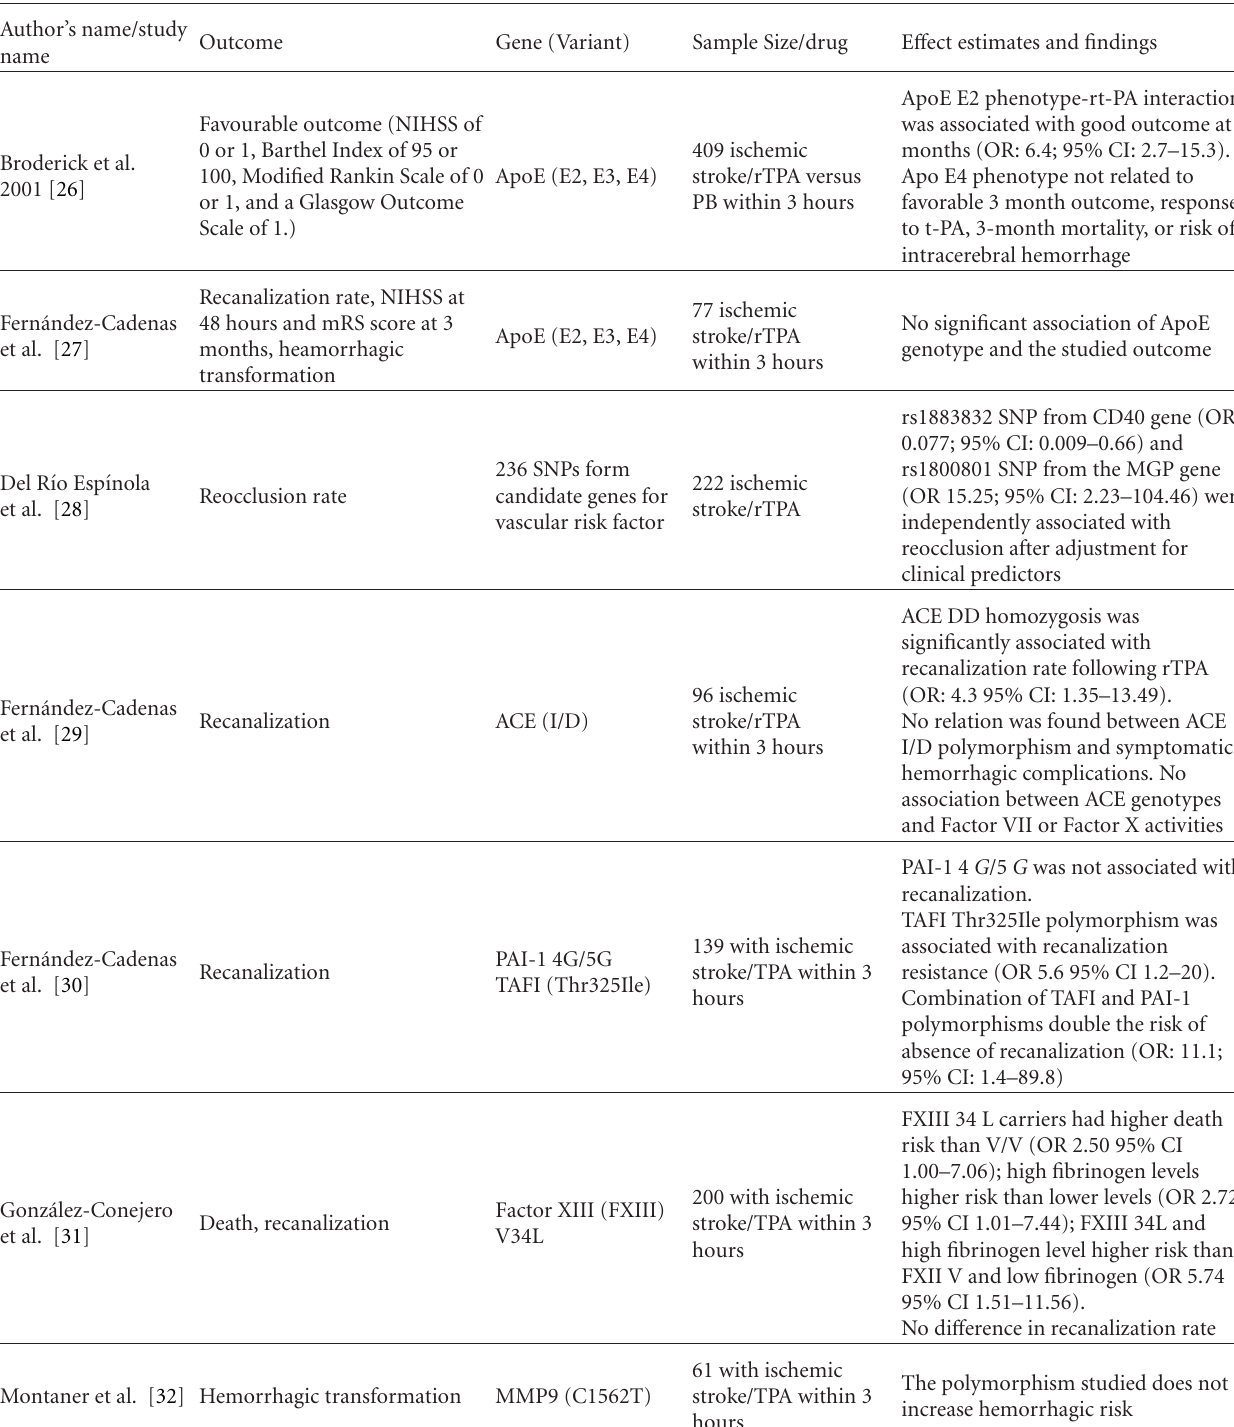
Table 3: Tissue plasminogen